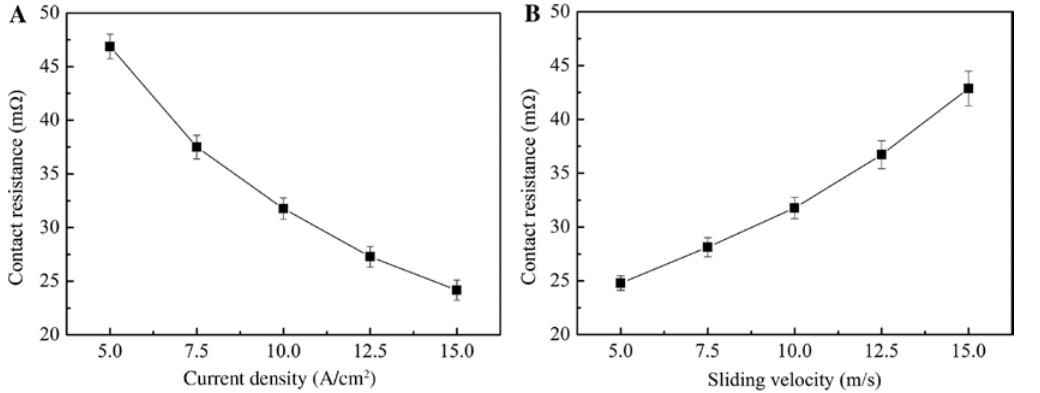
-graphite-multi-wall WS 2